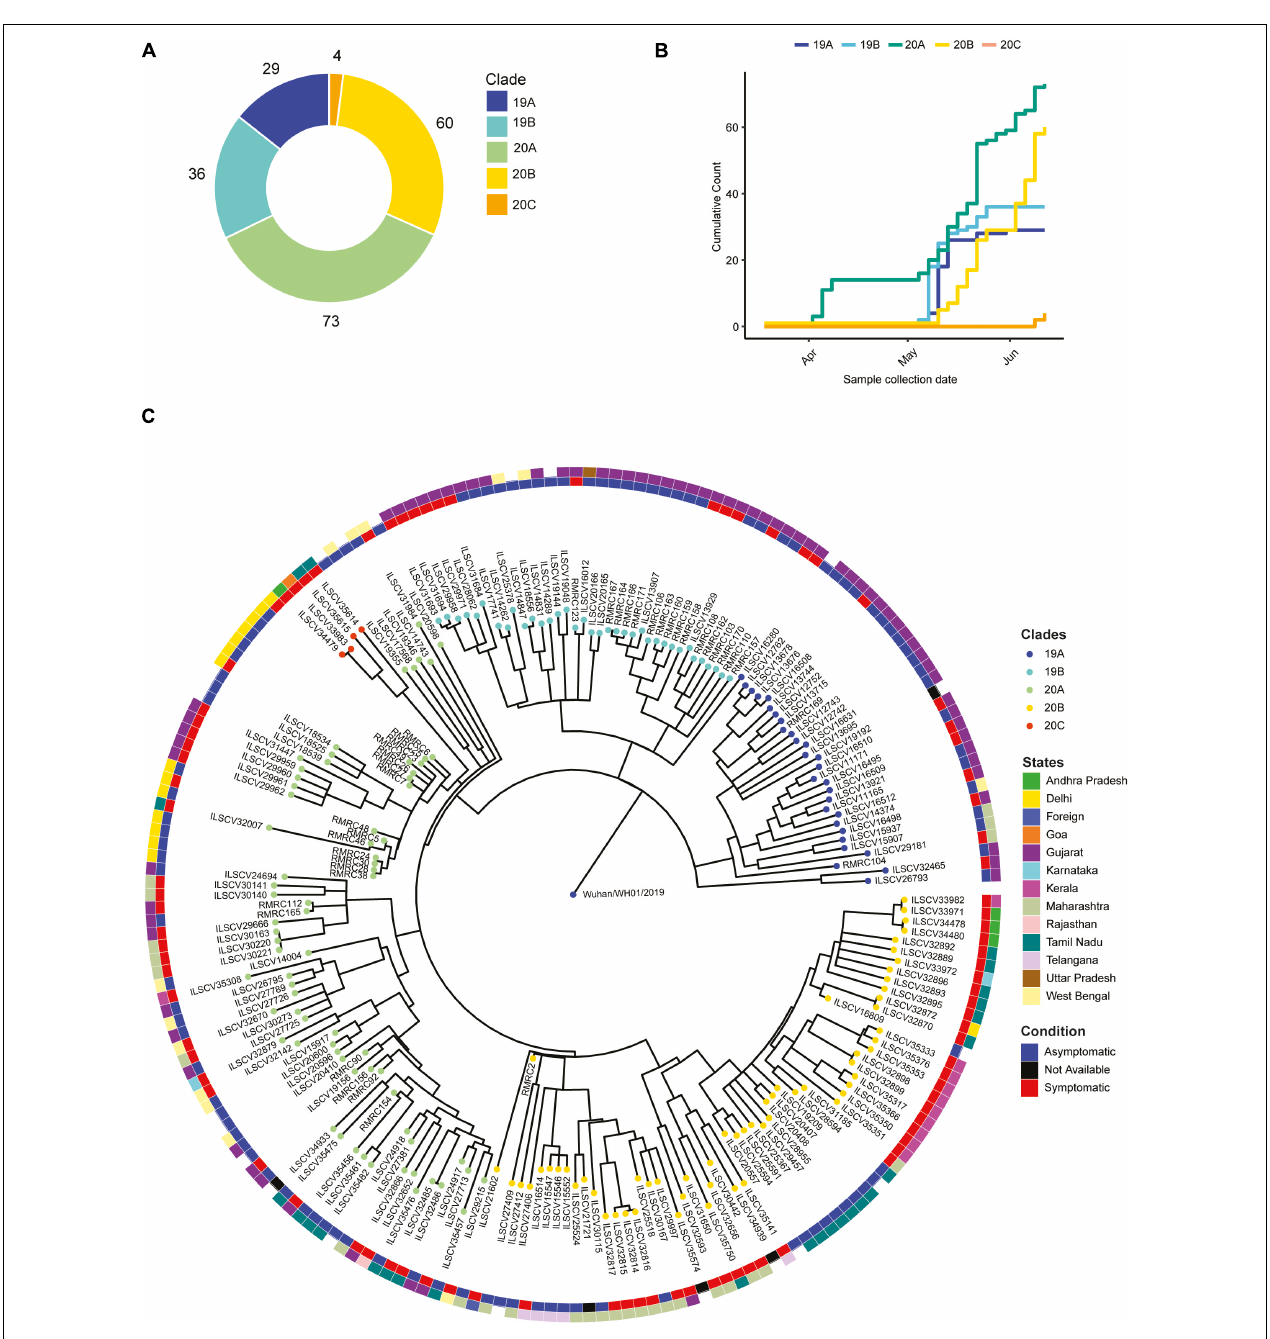
FIGURE 1 | Phylogenetic analysis of the SARS-Cov genomes and their distribution into different Nextstrain defined new clades. (A) A donut chart representing the sequenced sample ( n = 202) distribution across the clades (clade nomenclature obtained using Nextstrain). (B) Cumulative count of clades plotted against sample collection date showing abundance of clades with time. (C) Time tree (1,000 bootstraps) of the sequenced samples ( n = 202) generated using Nextstrain time-tree pipeline overlaid with clinical status (condition, inner circle) of the patients during sample collection, place of migration (state, outer circle), and clade information